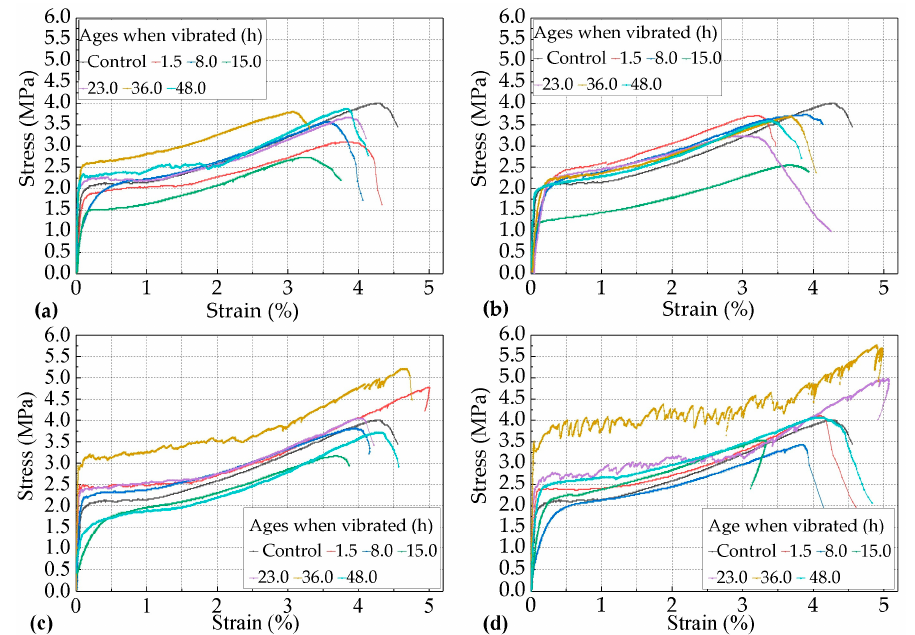
Figure 4. The strain- stress curves of the vibrated PVA-ECC groups and the control group at the ages of 1.5 h, 8.0 h, 15.0 h, 23.0 h, 36.0 h when vibrated subjected to the combination of a constant duration of 5.0 h and different levels of frequency of ( a ) 2.0 Hz, ( b ) 3. 0 Hz, ( c ) 4.0 Hz, and ( d ) 5.0Hz.